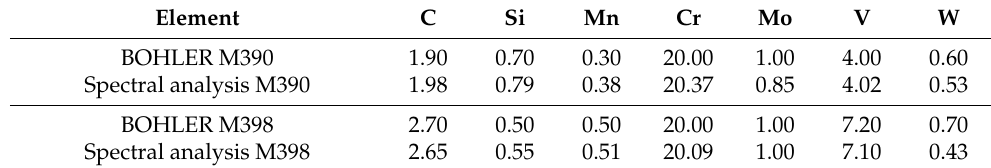
Table 2. Basic mechanical properties of the investigated M390 and M398 steel